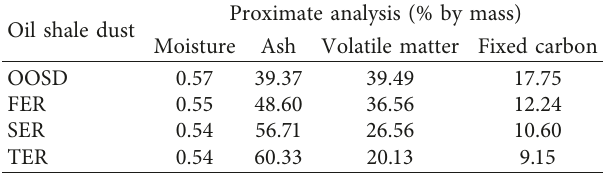
Table 1: Industrial analysis of oil shale dust. Proximate analysis (% by mass) Oil shale dust